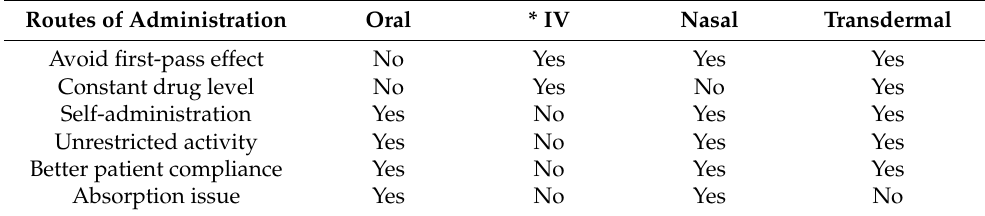
Table 1. Advantages and disadvantages of transdermal delivery of insulin as compared to other routes of